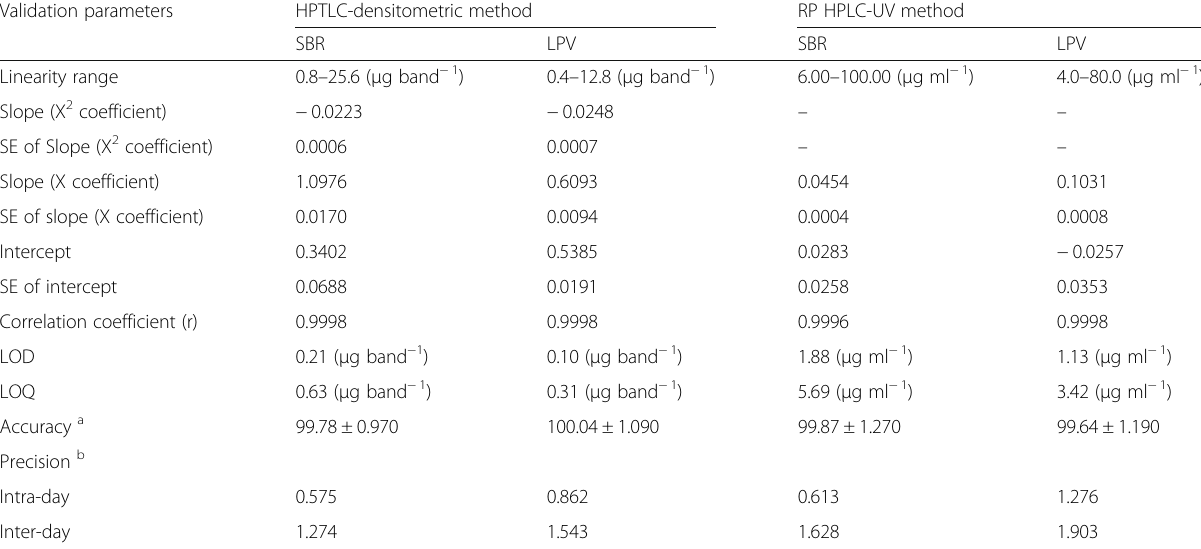
Table 2 Validation parameters of the regression equations and assay results of the proposed chromatographic methods for the simultaneous quantitation of SBR and LPV Validation